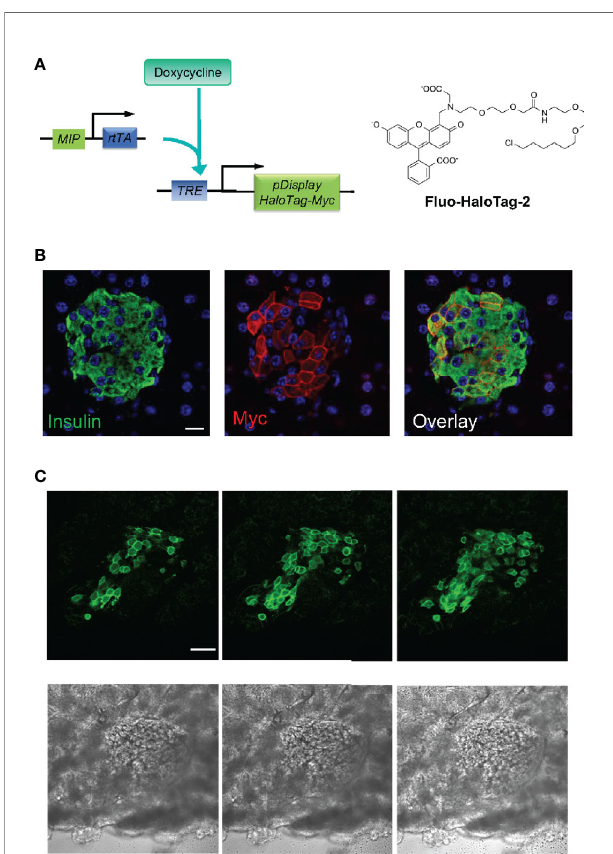
FIGURE 5 | In vivo dye labeling of islet beta cells expressing HaloTag. (A) Transgenic mice harboring two transgenes express the HaloTag-Myc protein in beta cells upon doxycycline (Dox) induction. HaloTag labels itself by reacting with its ligands such as Fluo HaloTag-2. (B) Con fi rmation of HaloTag-Myc protein expression in islet beta cells by immuno fl uorescence. The pancreatic tissue section of a transgenic mouse ( MIP-rtTA::TRE-pDisplay- HaloTag-Myc ) fed on Dox200 for 1 week was stained with antibodies against insulin and Myc. Scale bar = 10 µm. (C) Confocal images of a dissected pancreas from a transgenic mouse fed with doxycycline for 1 week. The mouse received Fluo HaloTag-2 through tail vein injection 30 min before pancreas harvest. Three consecutive confocal sections 10 µm apart along the z-axis were shown. The bottom row shows the corresponding bright fi eld images. Scale bar = 50